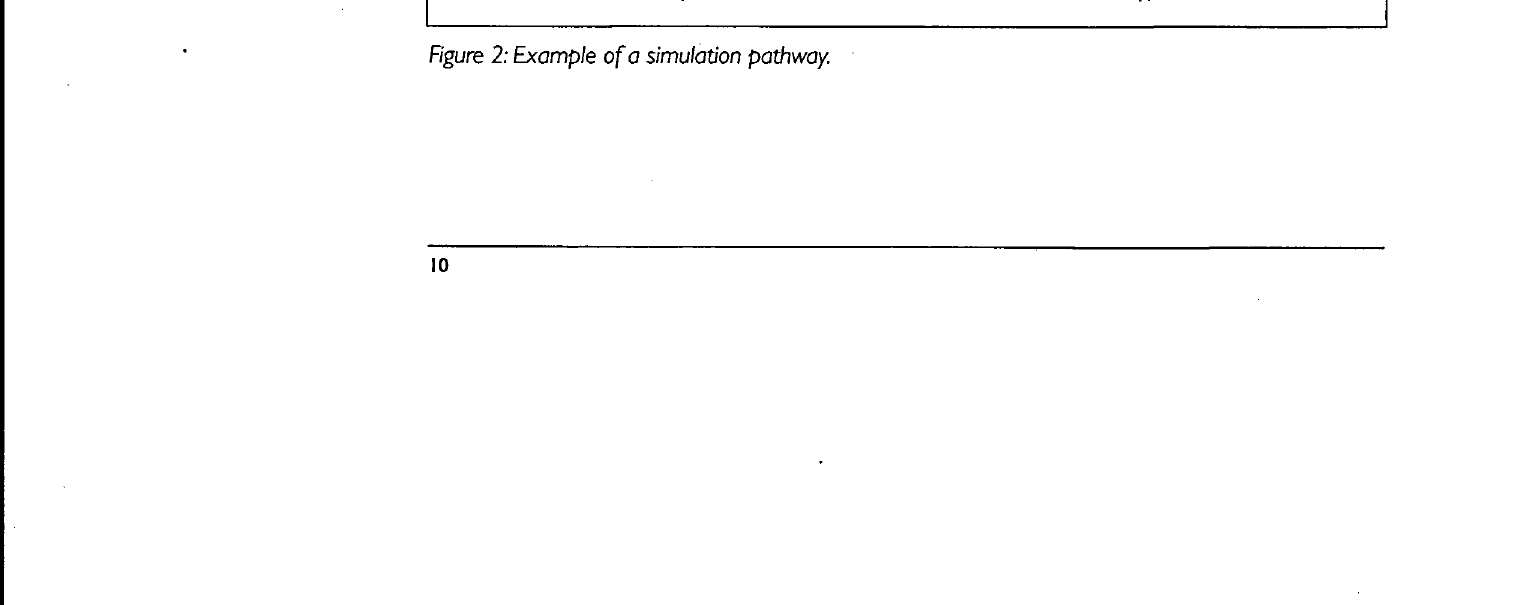
Figure 2: Example of a simulation